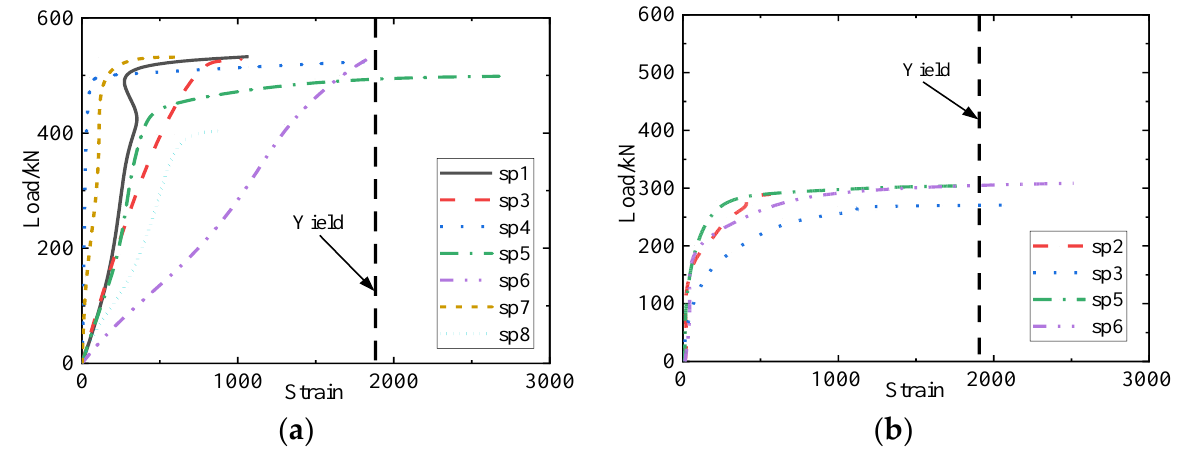
Figure 9. Load–strain curve of perfobond rib : ( a ) P-1 ; ( b ) P-4. Figure 10 shows the load – strain curves of the perforating rebar for the P-1 and P-4 specimens. The tensile strain is positive, and the compressive strain is negative. It can be seen that in the initial loading stage, the concrete dowel bore the loads. Hence, the rebar strain value was small. When the load increased, the perforating rebar and concrete dowel resisted shear together. Meanwhile, the rebar strain increased rapidly. In contrast, when the specimens reached the ultimate load, many of the reinforcing bars still did not yield, and the strain of the rebar exceeded the yield strain of 2215 με by the end of the loading. Simultaneously, the upper and lower parts of the perforating rebar were seen to be tensioned and compressed, respectively, indicating that the perforating rebar was subject to pull-bending action. Hence, it can be concluded that the perforating rebar in the concrete dowel provided both vertical shear contribution and axial force.